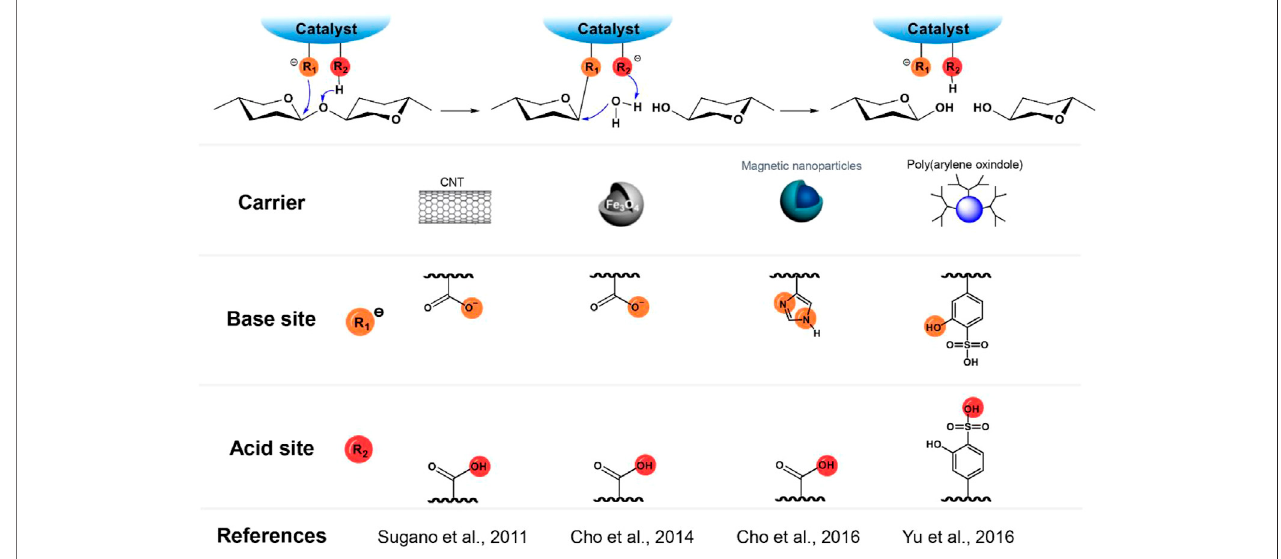
FIGURE 2 | A summary of acid-base pairs as catalytic sites of cellulose-mimetic solid acid catalysts and corresponding mechanism for the catalytic cleavage of glycosidic bonds in cellulose chain.